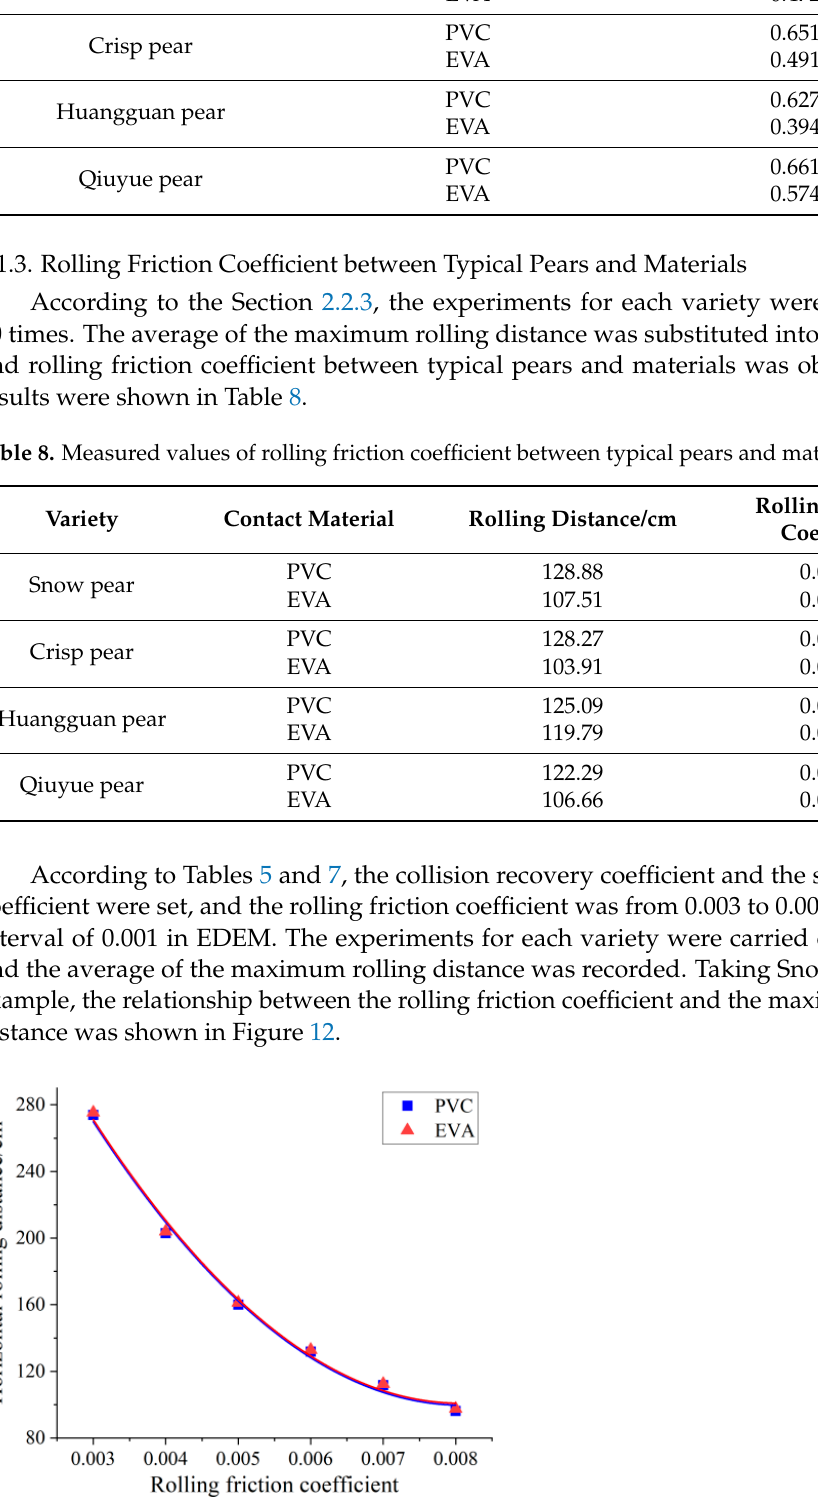
Table 7. Simulated values of static friction coefficient between typical pears and materials. Variety Contact Material